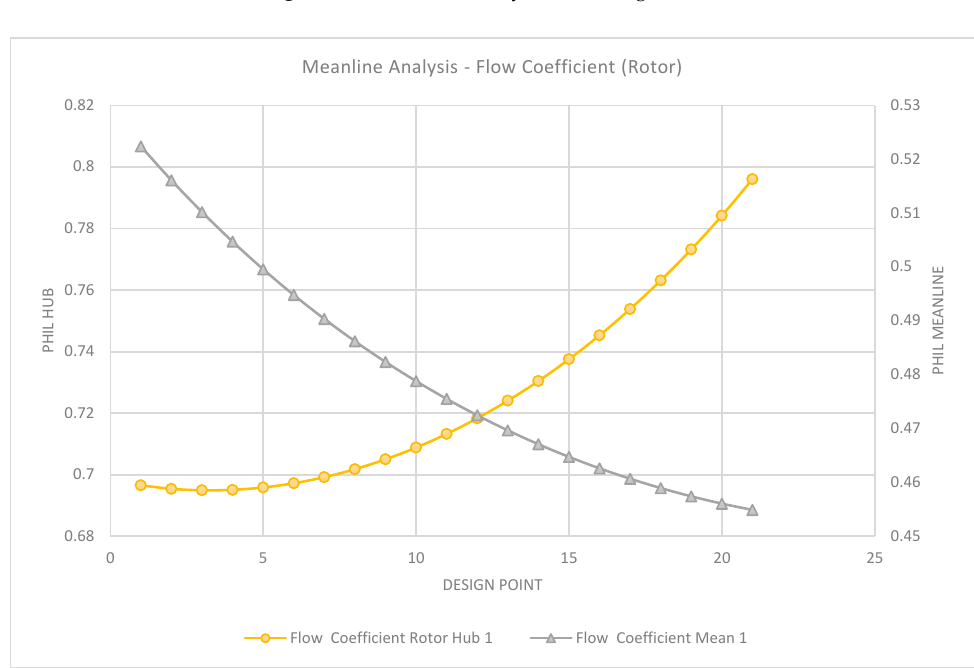
Figure 16. Meanline analysis—loading (rotor).